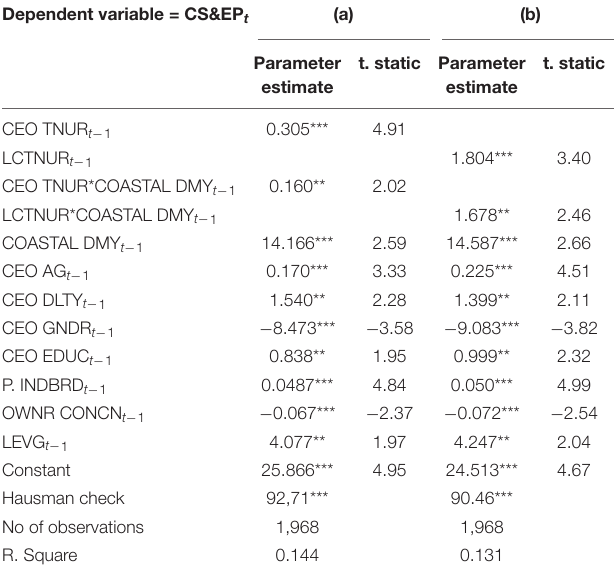
TABLE 6 | Resolving the endogeneity problem using 2SLS.